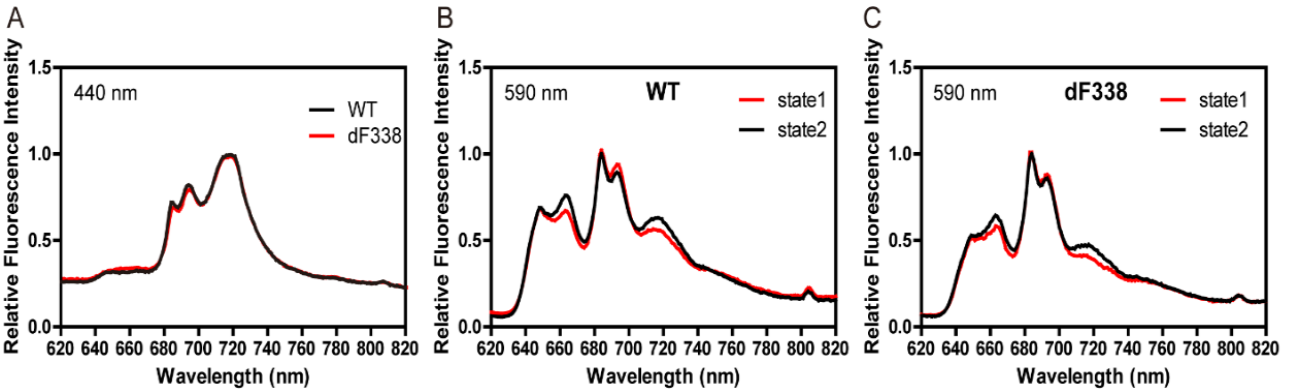
Figure 2. 77 K fluorescence spectra of the wild-type (WT) and dF338. ( A ) Emission spectra of WT (black line) and dF338 (red line) in state 2 conditions were collected with an excitation light at 440 nm. ( B , C ) 77 K fluorescence emission spectra of WT and dF338, respectively, were obtained with an excitation light at 590 nm. Cells were brought to state 1 by illuminating with blue light with DCMU (red line) and to state 2 with incubation in the dark (black line) before frozen in liquid nitrogen.